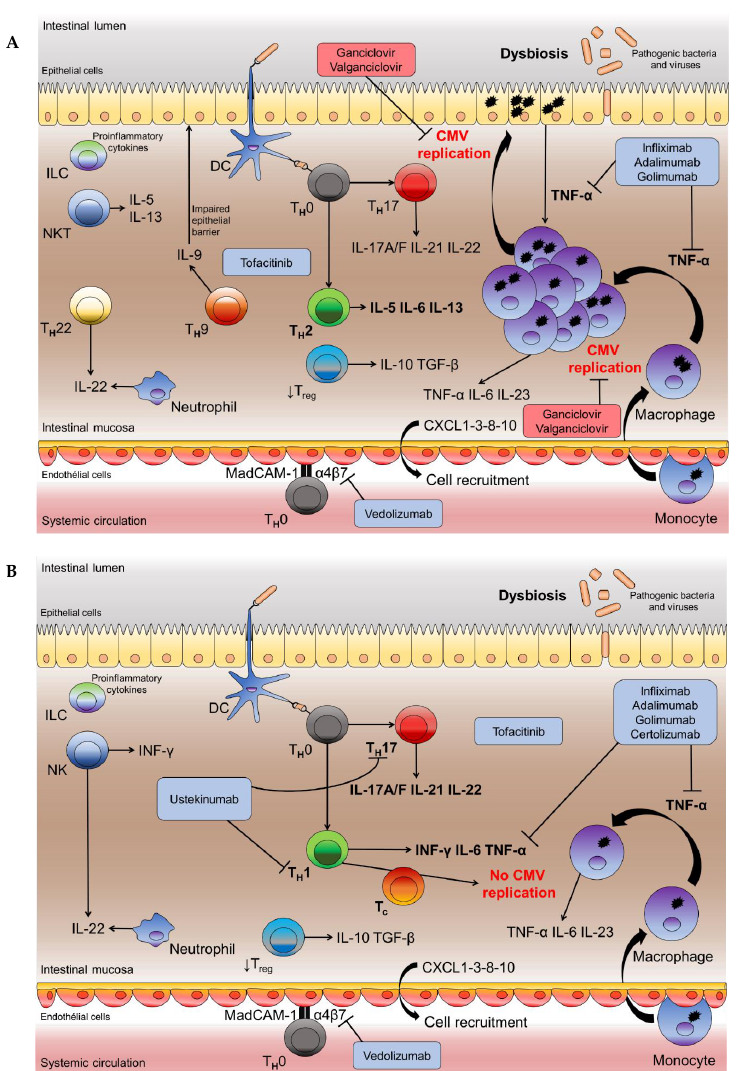
Figure 2. Pathophysiological hypothesis of ulcerative colitis and Crohn disease in the context of cytomegalovirus (CMV) viral reactivation. The rupture of the epithelial junctions increases intestinal permeability and facilitates the passage of microorganisms from the intestinal lumen to the lamina propria. Microorganisms are processed by dendritic cells (DCs) and macrophages through toll-like receptor (TLR). Antigens are primed by human leukocyte antigen (HLA) type II to be presented to T helper cells (T H ) by TCR (T cell receptor). In the presence of pathogenic bacteria and viruses